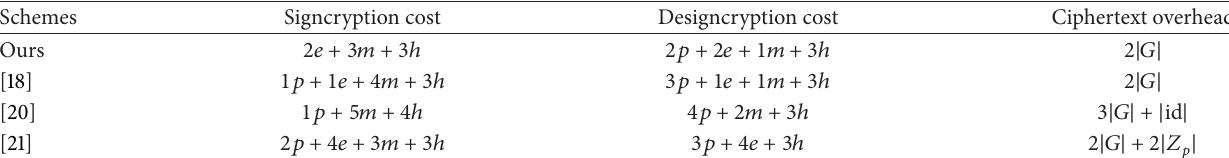
Table 2: Performance of the CBSC schemes.